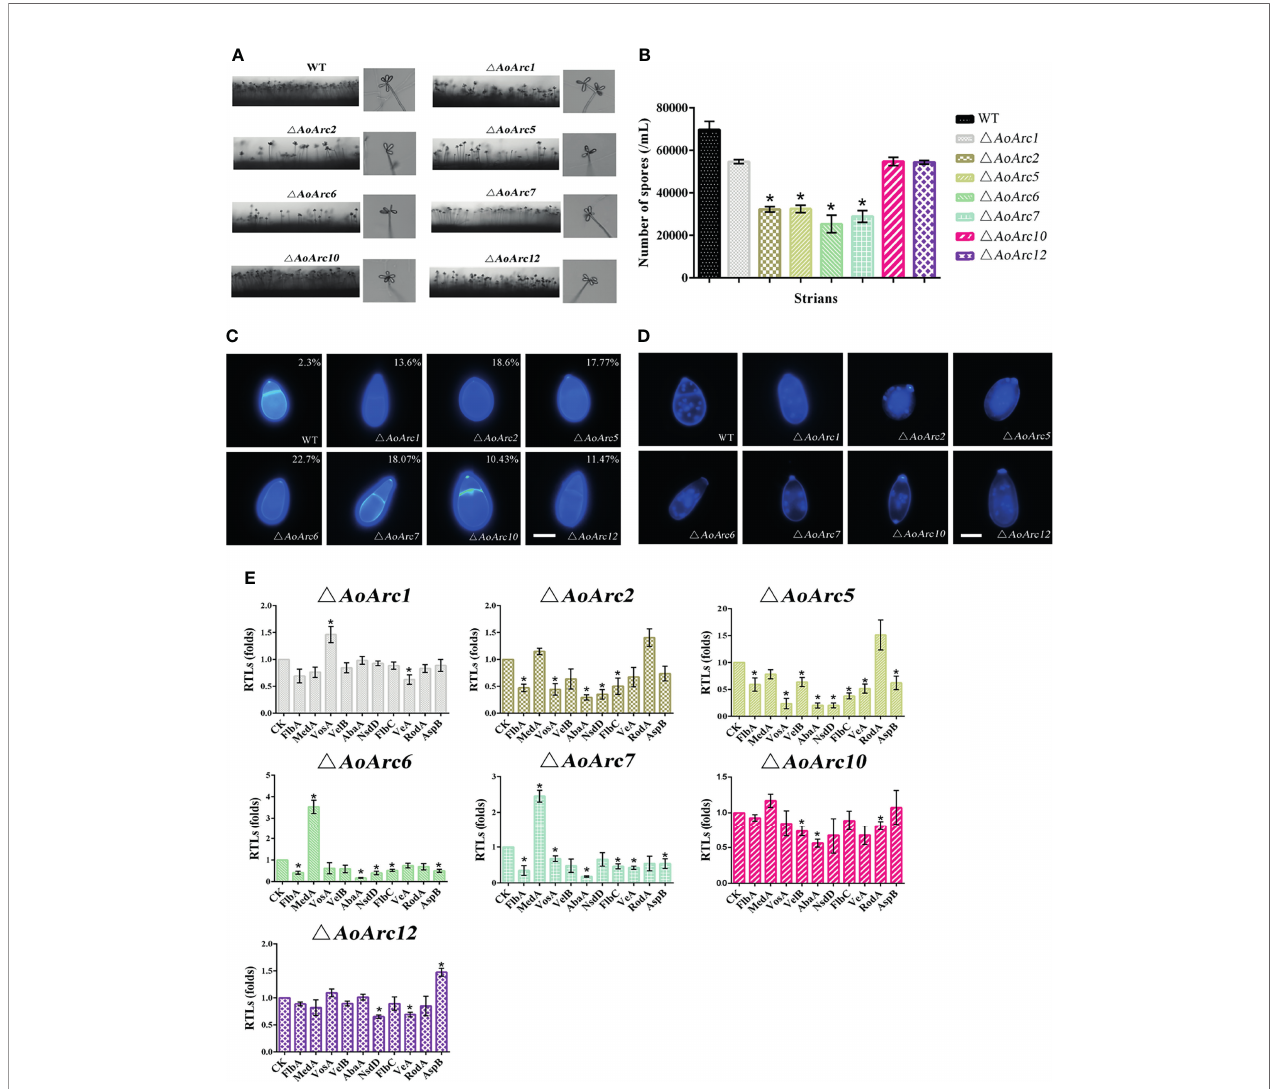
FIGURE 5 | Comparison of aerial hyphae, conidia yield, morphology, number of conidia nuclei, and sporulation-related gene transcription between WT and AoArc mutants. (A) Comparison of conidiophores between WT and AoArc mutants on TYGA at 28°C for 7 days. (B) The conidia yields collected from strains grown on CMY for 7 days. (C) The spores are stained by CFW, and the percentage in the upper right corner indicates the conidia deformation rate. Bar: 10 m m. (D) After the fungal strains were grown on CMY medium for 7 days, the conidia of WT and each mutant strain were collected and stained with 4 ′ ,6-diamidino-2-phenylindole (DAPI); the samples were inspected with an inverted fl uorescence microscope. Bar: 10 m m. (E) Comparison of sporulation-related genes between WT and AoArc mutants. CK ( A. o b -tubulin ) is expressed as the standard of RTL statistical analysis. Each experiment was performed three times. Error bars: standard deviation; asterisk: signi fi cant difference between mutant and WT (Tukey ’ s HSD, p <